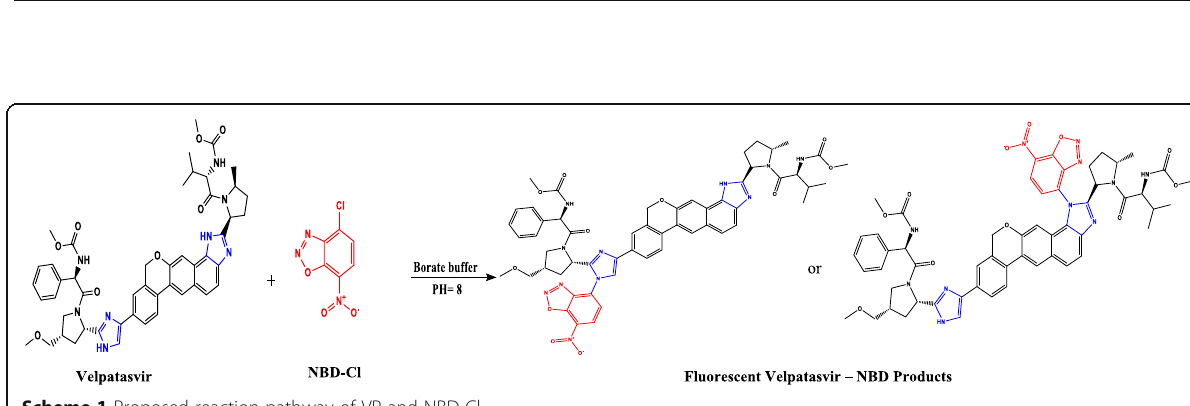
Fig. 5 a Absorption spectra of the colored reaction product obtained from VP, SF, and SF-VP mixture reaction with 0.2% w/v NBD-Cl. b Fluorescence excitation (1) and emission (2) spectra of the reaction product of VP (5 μ g/mL) with 0.2% w/v NBD-Cl. c Absorption spectra of the colored reaction product obtained from VP, SF, and SF-VP mixture reaction with MBTH in presence of the oxidant Fe(III) chloride